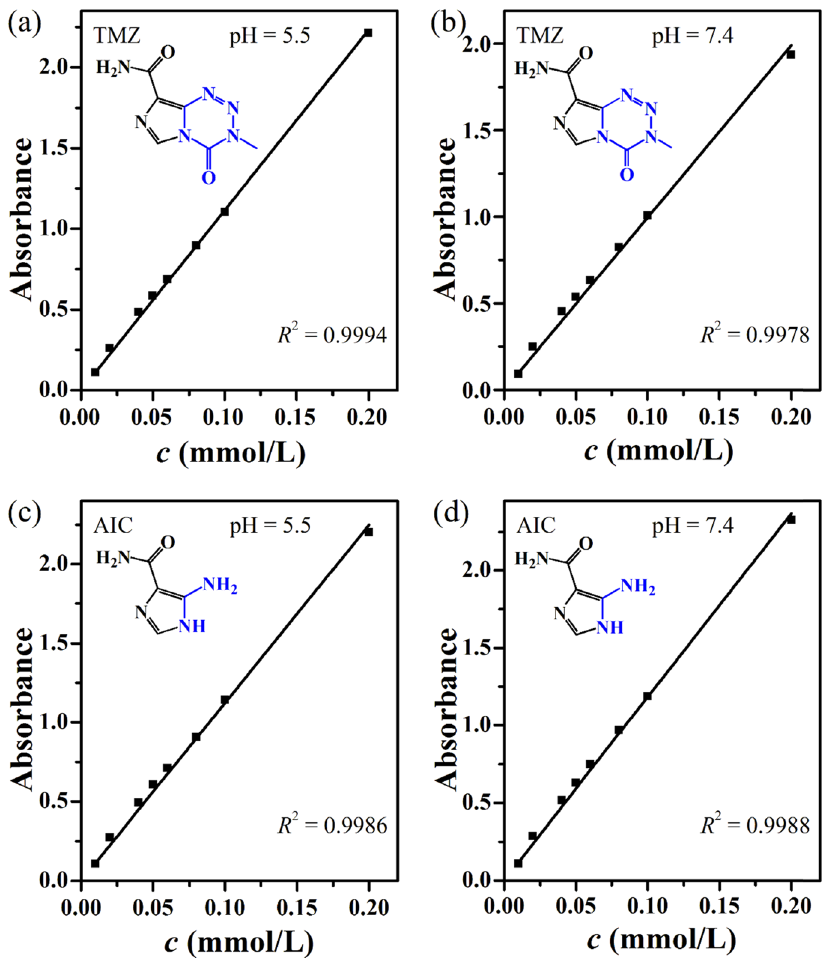
Figure A5: The calibration curves of TMZ and its degradation product ( AIC ) . The aqueous solutions of both TMZ and AIC were freshly prepared. At pH values of 5.5 and 7.4, respectively, the slope for TMZ was 11.162 and 9.958 ( a and b ) , whereas the slope for AIC was 11.238 and 11.846 ( c and d ) ,